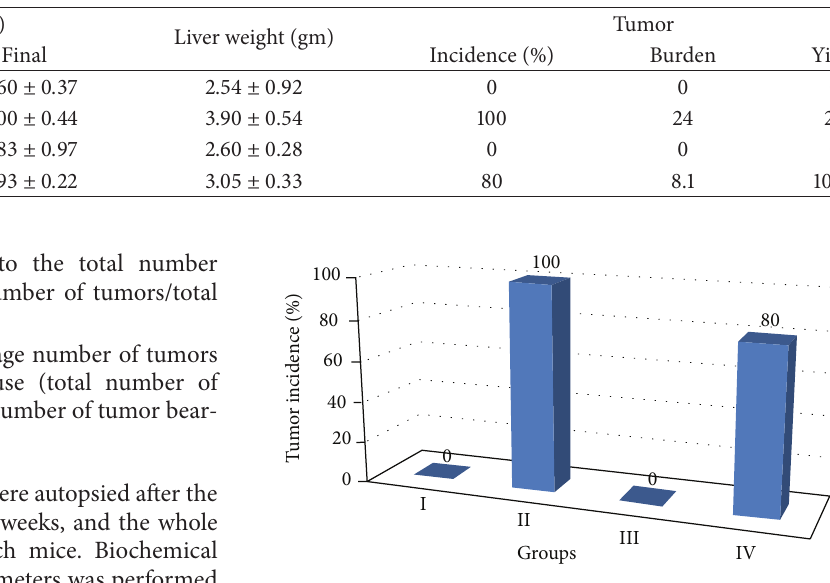
Figure 1: Variations in tumor incidence (%) after DENA/CCl 4 induced hepatic carcinogenesis with/without ACE